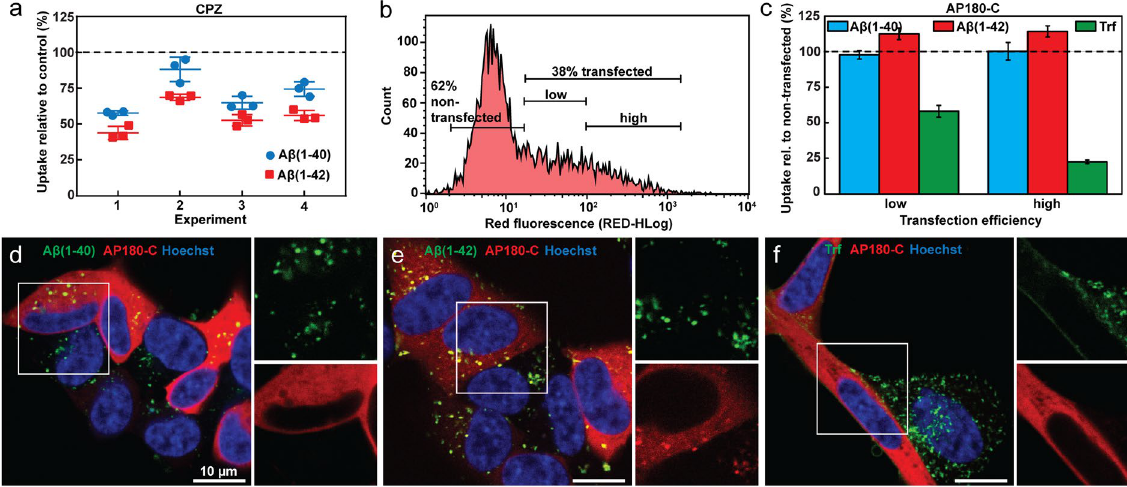
Figure 4. Uptake of A β (1–40), A β (1–42) and Trf in SH-SY5Y cells under conditions that perturb clathrin mediated endocytosis. ( a ) Uptake of HF488-labelled A β (1–40) and A β (1–42) in cells treated with CPZ (5 µ g/ml). The peptide uptake is reported as mean cellular uptake relative to control (cells not treated with inhibitor) for 4 independent experiments, each performed in triplicate. Statistical analysis of the data performed by one-way ANOVA with matched data followed by multiple comparisons with Bonferroni post-hoc test gives adjusted p-values for the individual comparisons made as: A β (1–40) vs. control 0.0007; A β (1–42) vs. control < 0.0001; A β (1–40) vs. A β (1–42) 0.0289. ( b ) Flow cytometry histogram of live cells 24 h post transfection with mRFP-labelled AP180-C: the cells were gated for peptide uptake based on transfection efficiency as measured by the intensity of the mRFP label. ( c ) Uptake of HF488-labelled A β (1–40), A β (1–42) or AF647-labelled Trf in AP180-C transfected cells, gated as in ( b ) and related to peptide uptake in cells gated as non-transfected (N = 2, n = 2–4). ( d – f ) Confocal imaging of AP180-C (red) transfected cells imaged 24 h post transfection and incubated with HF488-labelled ( d ) A β (1–40), ( e ) A β (1–42) or ( f ) AF488-labelled Trf (green). In all experiments the concentration of A β was 1 μ M and the concentration of Trf was 5 µ g/ml. Cells were incubated with A β for 1 h and Trf for 5 min (flow cytometry) or 10 min (confocal